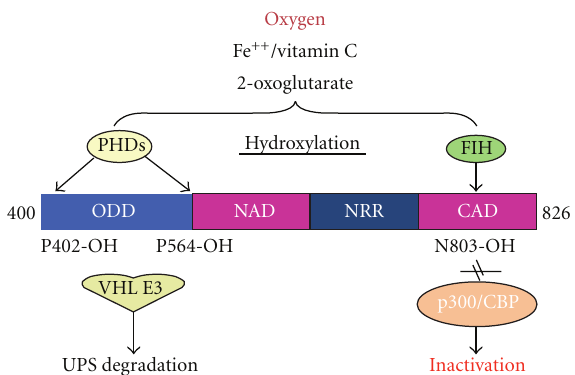
Figure 2: Regulation of HIF-1 α by Oxygen-Dependent Hydroxylation. HIF function is continuously regulated by the concentration of molecular oxygen, representing an essential part of physiological feedback loop. In this feedback loop, oxygen sensing is achieved by oxygen- dependent hydroxylation of specific amino acid residuals of HIF- α . Hydroxylation of two prolyl residuals leads to ubiquitination and proteasome-dependent degradation of HIF- α . Hydroxylation of an asparagine residual located at the CAD by FIH impairs its interaction with coactivator p300 or CBP, thus repressing the transactivation activity. Note that the hydroxylation reactions require ferrous ion and ascorbic acid as cofactors, and 2-oxoglutarate as cosubstrate.